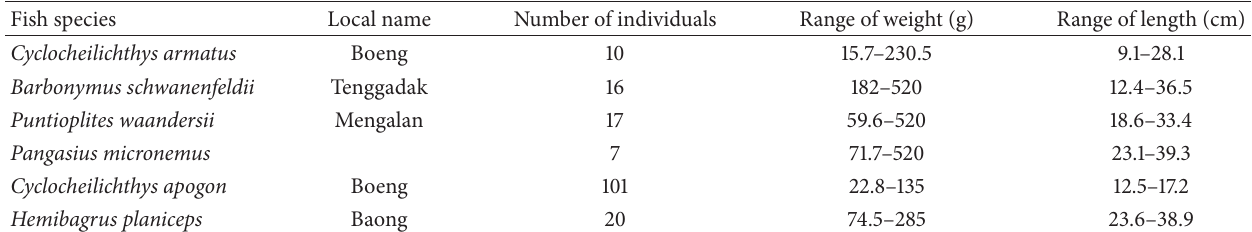
Table 2: The number of samples and corresponding length and weight of various